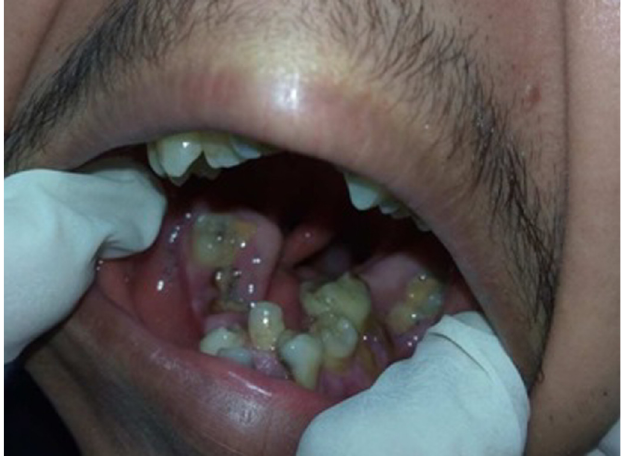
Fig. 1. Showing malaligned teeth in the mandibular arch, along with absence of the